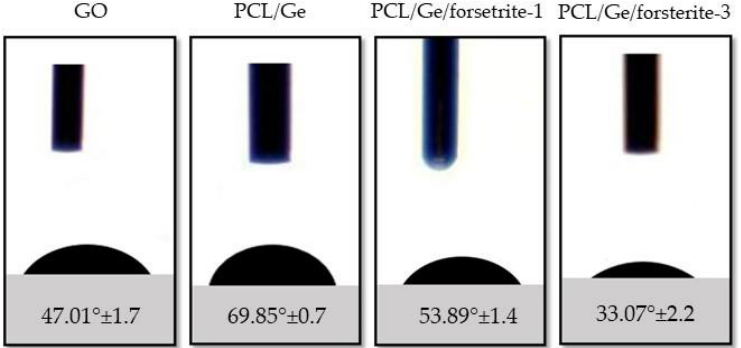
Figure3. ThewatercontactanglesofGOlayerandPCL / Genanofiberscontaining0, Figure 3. The water contact angles of GO layer and PCL/Ge nanofibers containing 0, 1 and 3 wt.% forsterite.